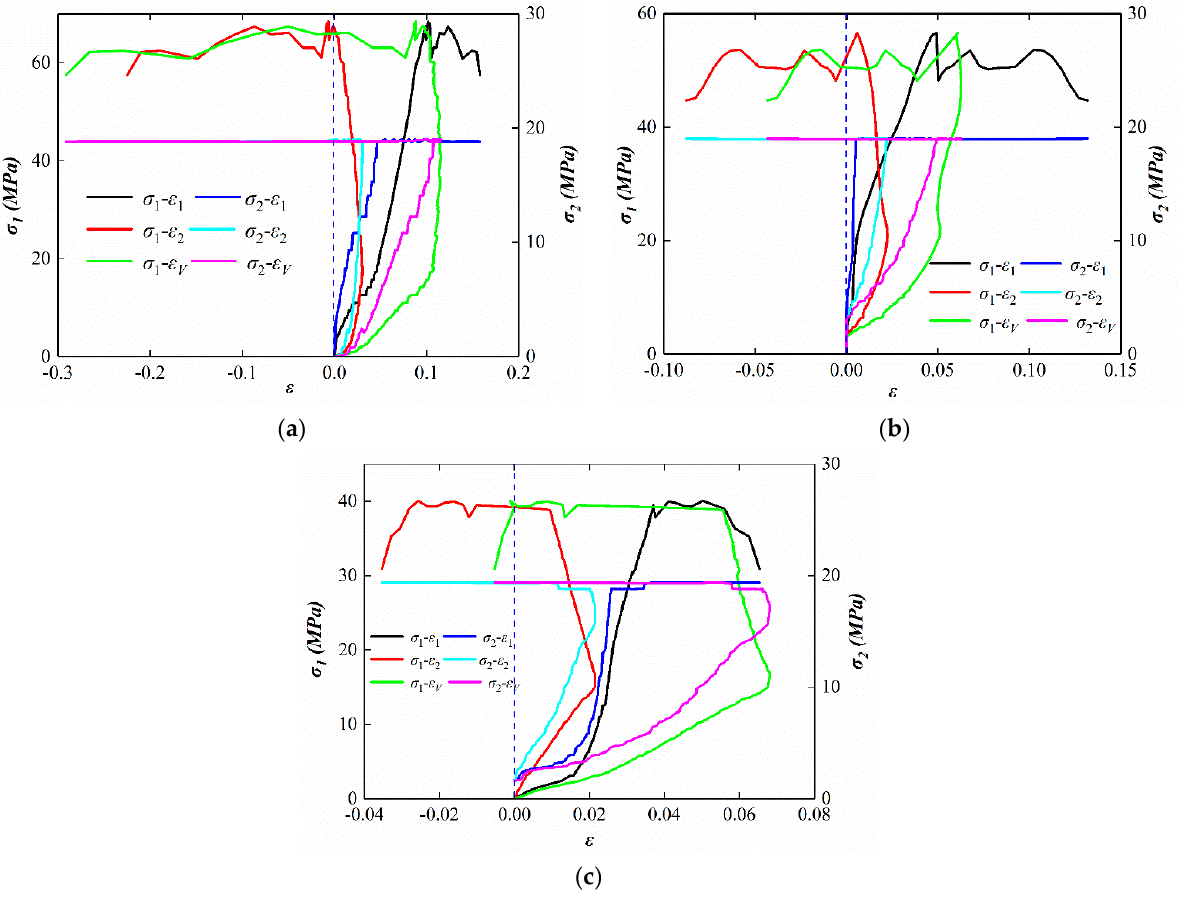
Figure 3. Conventional triaxial test stress–strain curves at different gas pressure. ( a ) Stress–strain curve of 0.2 MPa. ( b ) Stress–strain curve of 0.5 MPa. ( c ) Stress–strain curve of 0.8 MPa.